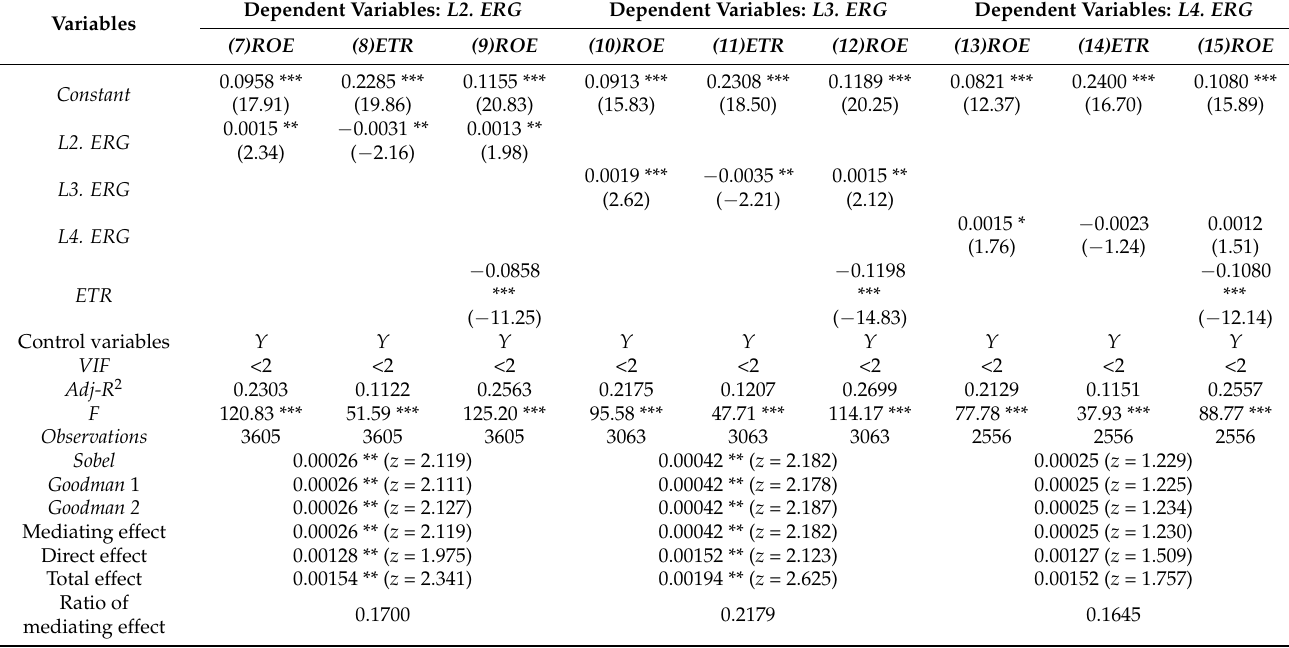
Table 11. Robustness testing of different measurement indicators (lag phase II, III and